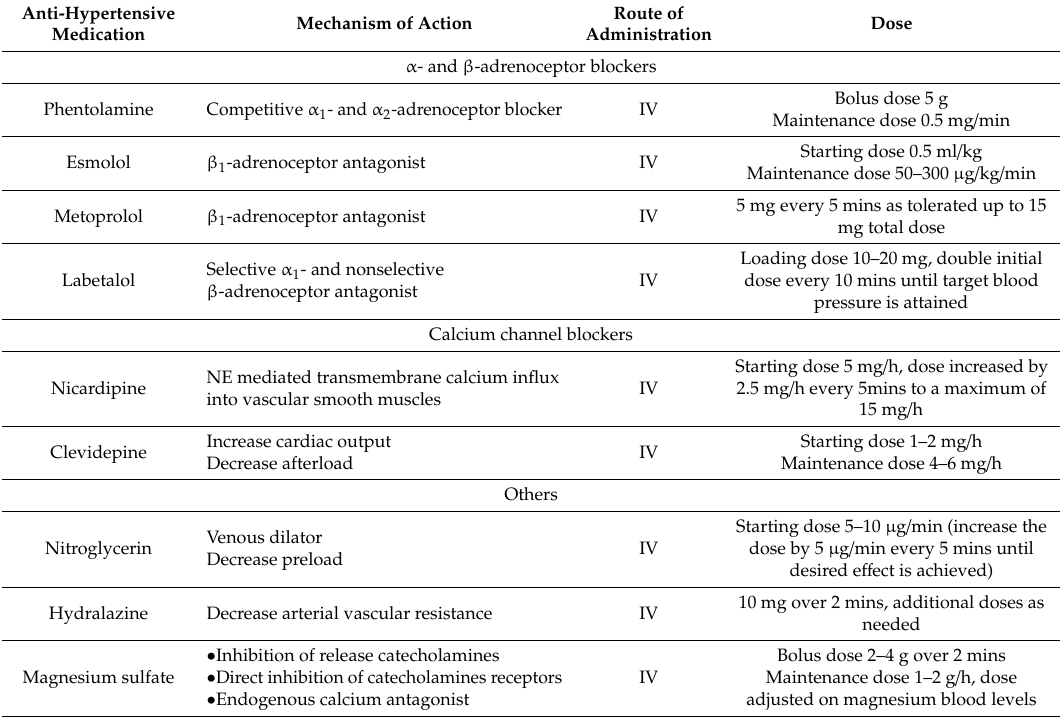
Table 3. Anti-hypertensive medications used in hypertensive crisis after pheochromocytoma and paraganglioma (PPGL)